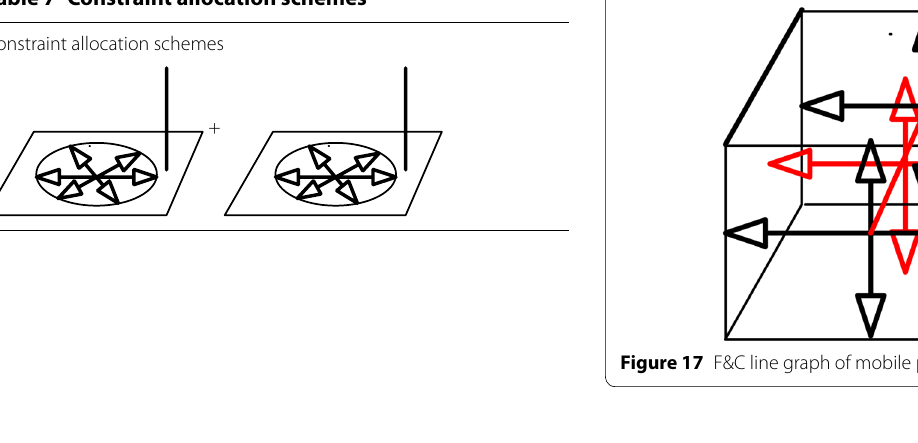
Table 8 Type synthesis process Branch chain constraint line graph and dual DOF graph with couple